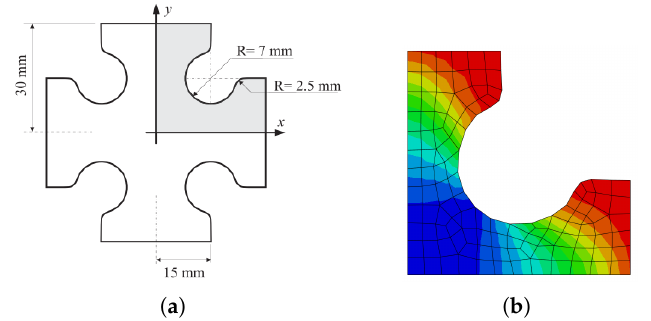
Figure 8. ( a ) Cruciform geometry [63] and ( b ) mesh for the parameter identification problem.